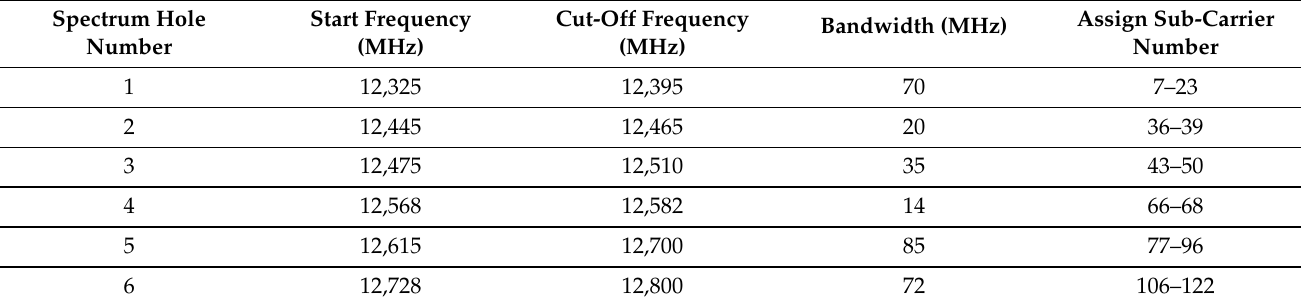
Figure 3. Spectrum sensing results of Ku-band satellite. Table 2. Spectrum holes extracting and subcarrier